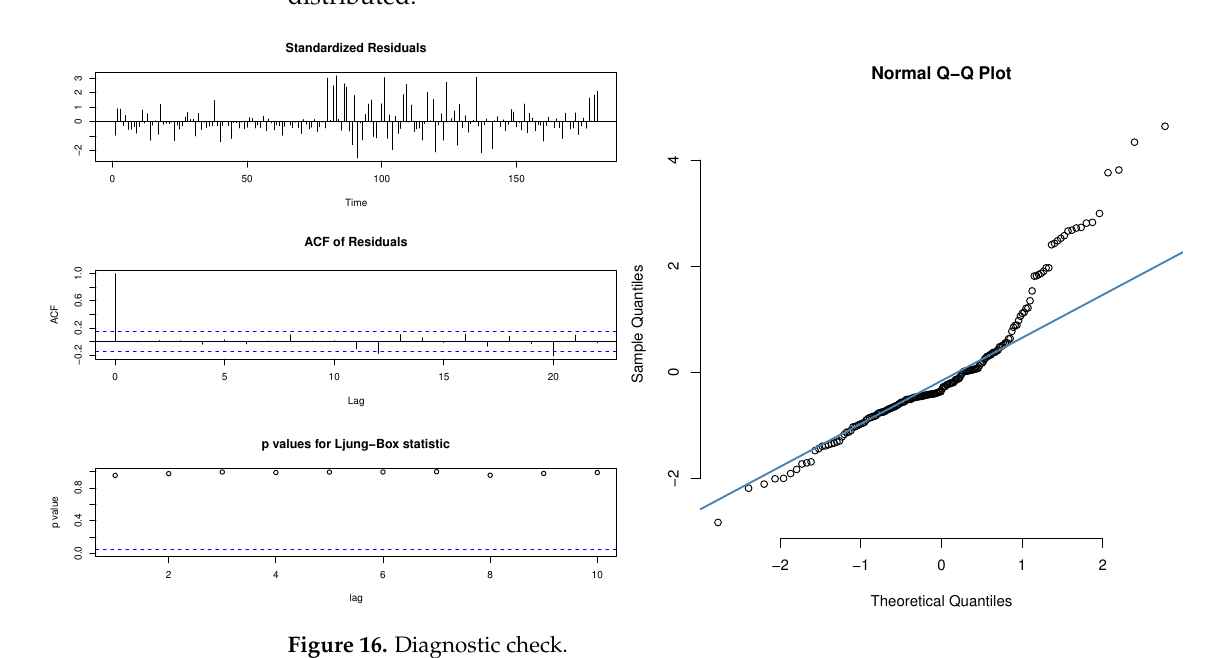
Figure 16. Diagnostic check.